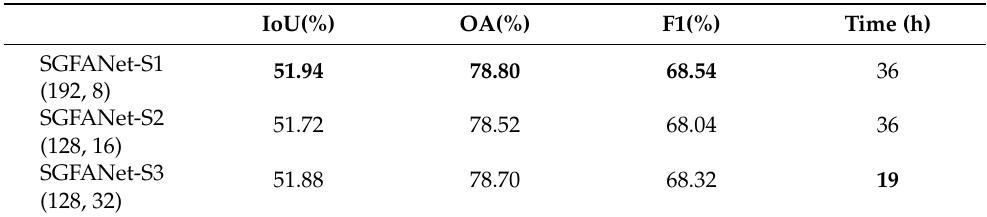
Figure 15. The IoU on DREAM-A+ val of different combinations of sampled edges ( N e ) and corners ( N c ) under different strategies. First, we sampled the edge points while N c remained zero (shown in ( A )). Then, based on the best N e , we sampled the corner (shown in ( B )). The best combination was 192 and 8 for N e and N c , respectively. Second, we sampled the corners (shown in ( C )) and then sampled the edges (shown in ( D )), and the best combination was 128 and 16. Third, we kept the ratio of N e and N c to 4:1, and the best combination was 128 and 32 as shown in ( E ). Table 4. Comparisons on DREAM-A+ of different N e and N c adjusting strategies. The bold values in each column means the best